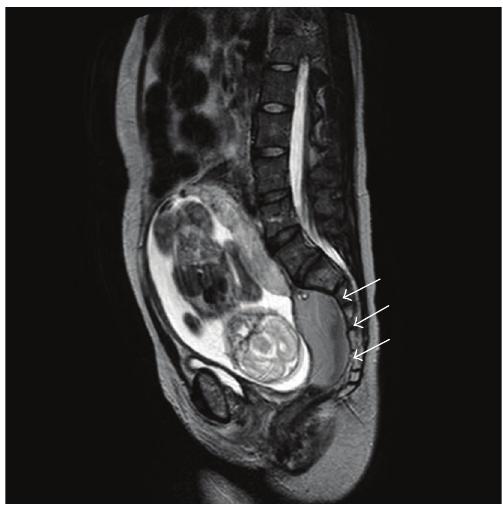
Figure 2: MRI at 47 days after delivery. Arrows point to placental